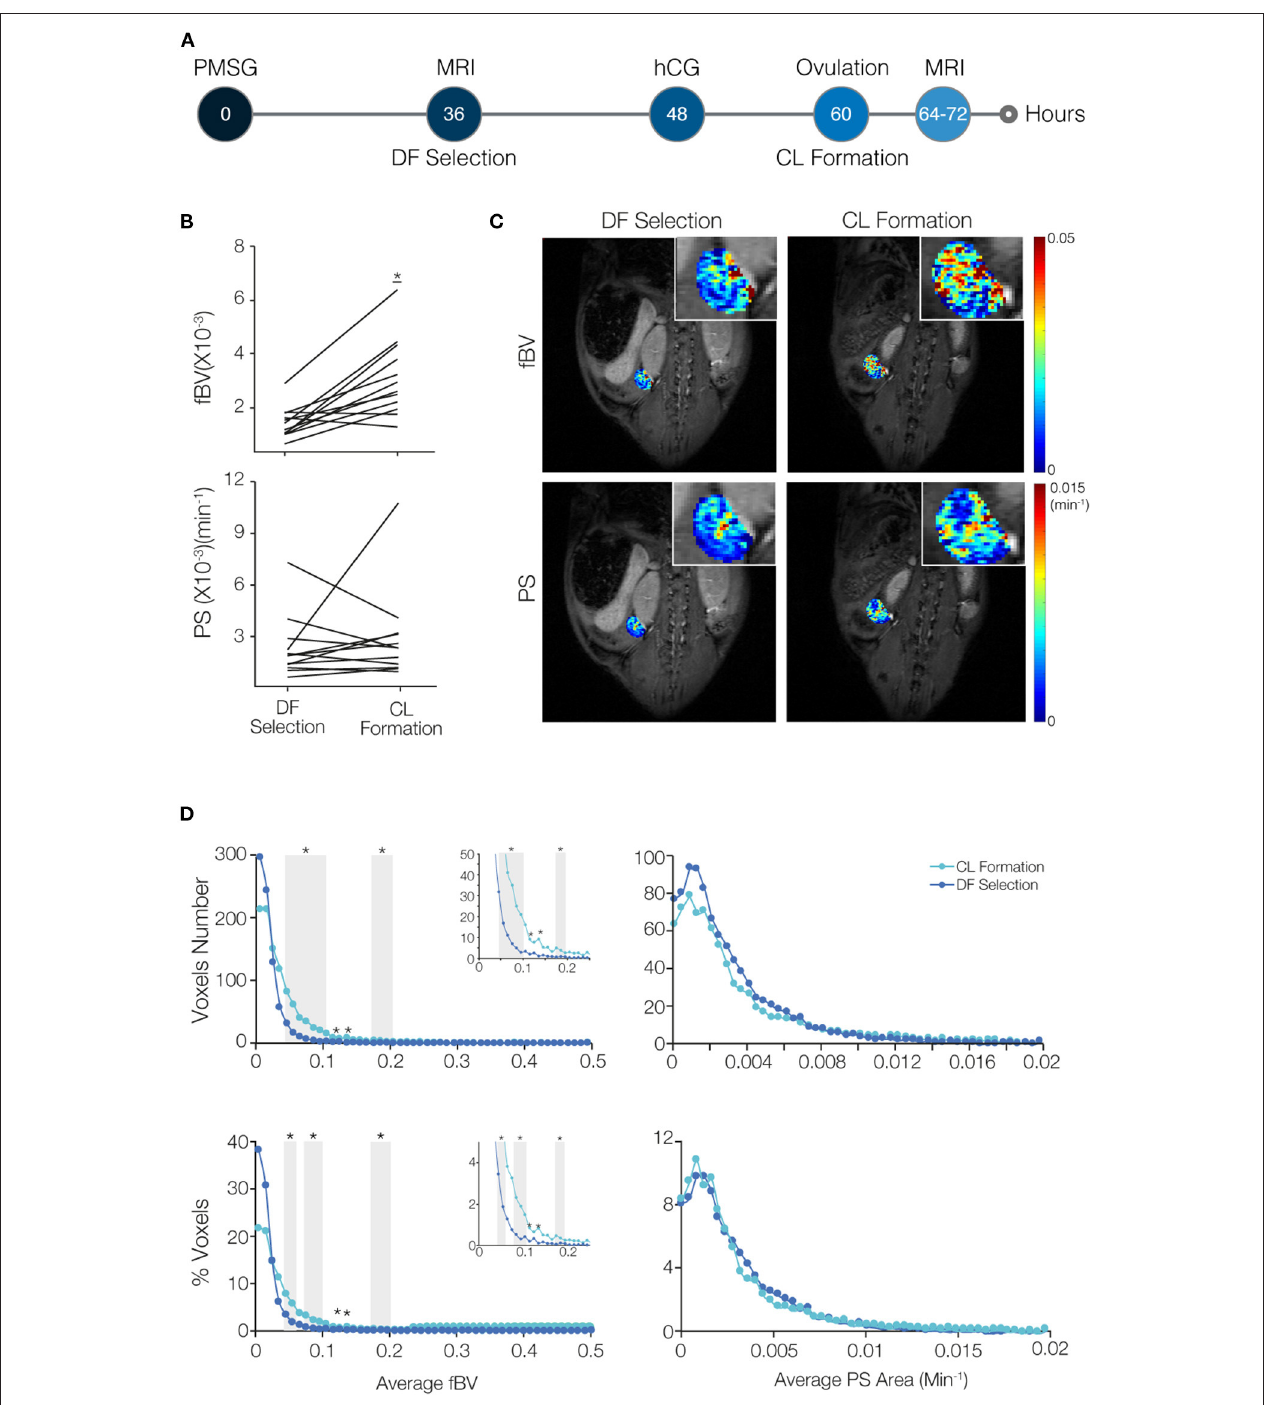
FIGURE 2 | Blood volume increases while permeability surface area remains restrained in the transition of the dominant follicle (DF) to form the corpus luteum (CL). (A) Mice were imaged by DCE-MRI soon after DF selection (36–48h after PMSG injection) and then injected with hCG. On the next day, after ovulation occurred and at the time of CL formation, mice were imaged again ( n = 8 mice, 12 ovaries). (B) Fractional blood volume (fBV) and permeability surface area product (PS) averaged over the entire ovary voxels. Significant change is indicated (* indicates p-value = 0.0006). (C) Maps of fBV and PS with enlarged ovary region in the inset. (D) Histogram analysis of the total number and percent of voxels in each value range of fBV and PS. Ranges with significant increase in voxels with low values of fBV are indicated by gray background (* indicates p -value < 0.05). Inserts show the enlargement of the histogram at the fBV range of 0–0.25.